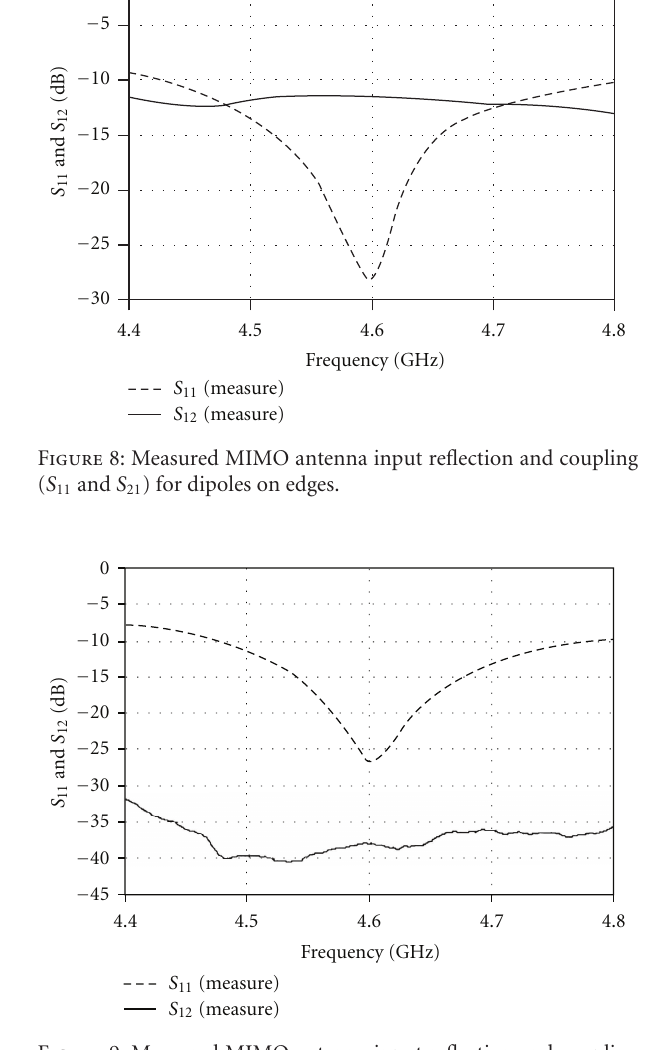
Figure 9: Measured MIMO antenna input reflection and coupling ( S 11 and S 21 ) for dipoles on separated